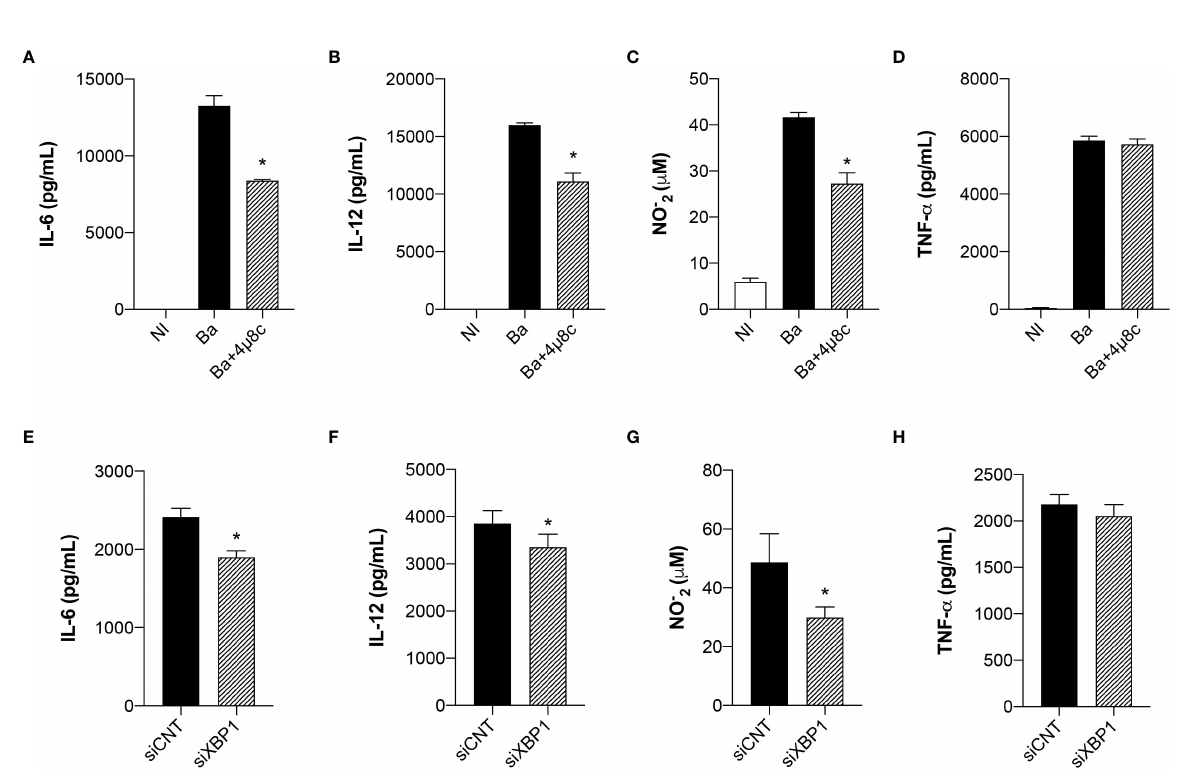
FIGURE 2 The UPR modulates the in fl ammatory response in infected macrophages. (A) IL-6, (B) IL-12 and (D) TNF- a produced by macrophages from C57BL/6 mice non-infected (NI), infected with B abortus (Ba) or pre-treated with 4 m 8c (50 m M) and infected with B abortus (Ba+4 m 8c), detected in cell supernatants using ELISA. (C) NO 2 − (nitrite) accumulation in the media of macrophages from C57BL/6 mice non-infected (NI), infected with B abortus (Ba) or pre-treated with 4 m 8c (50 m M) and infected with B abortus (Ba+4 m 8c), measured by Griess reaction. (E) IL-6, (F) IL-12 and (H) TNF- a produced by macrophages from C57BL/6 mice subjected to speci fi c XBP1 gene knockdown and then infected with B abortus . (G) NO 2 − (nitrite) accumulation in the media of macrophages from C57BL/6 mice subjected to speci fi c XBP1 gene knockdown and then infected with B abortus . The data